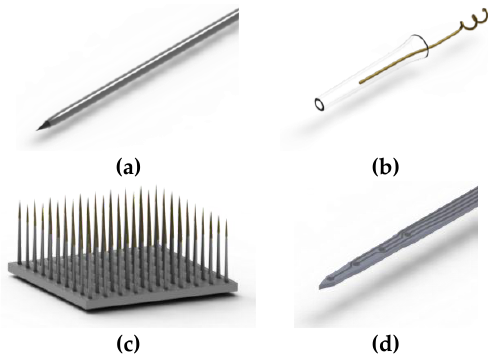
Figure 2. Illustrations of significant rigid probe designs: ( a ) Insulated microwire with exposed tip; ( b ) Glass cone with insulated wire; ( c ) Utah style electrode array; ( d ) Michigan style multi-site probe.